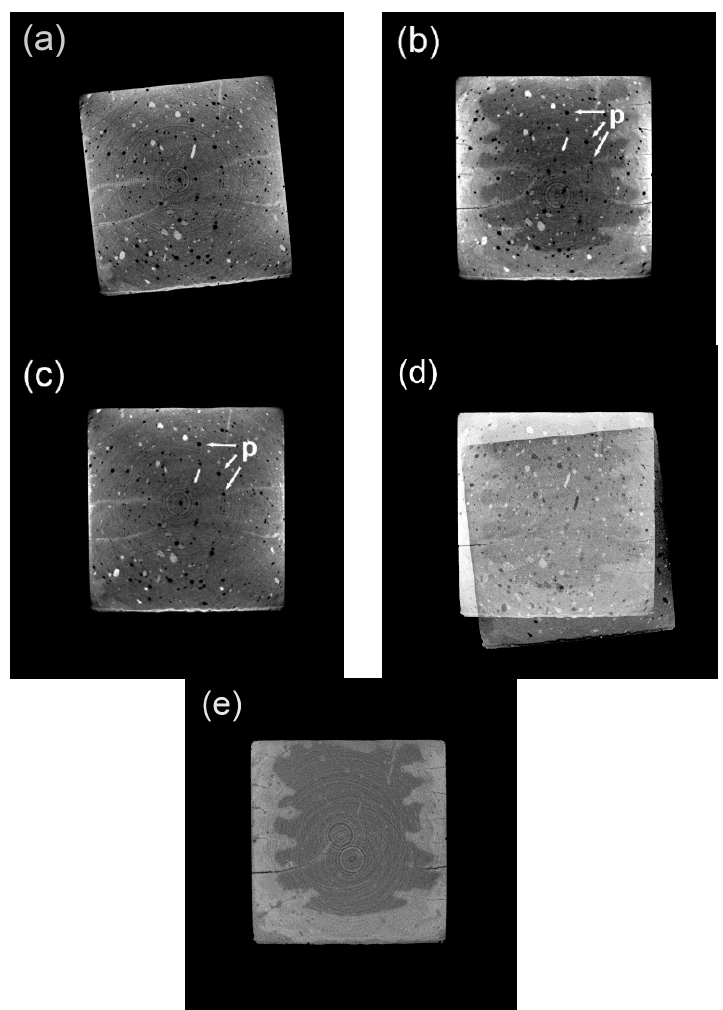
Figure 3. Typical cross-sectional images at different carbonation ages: ( a ) sample at zero days of carbonation (before registration); ( b ) sample at seven days of carbonation; ( c ) sample at 0 day of carbonation (after registration); ( d ) subtracted image through b minus a; and ( e ) subtracted image through b minus c. P, pores.